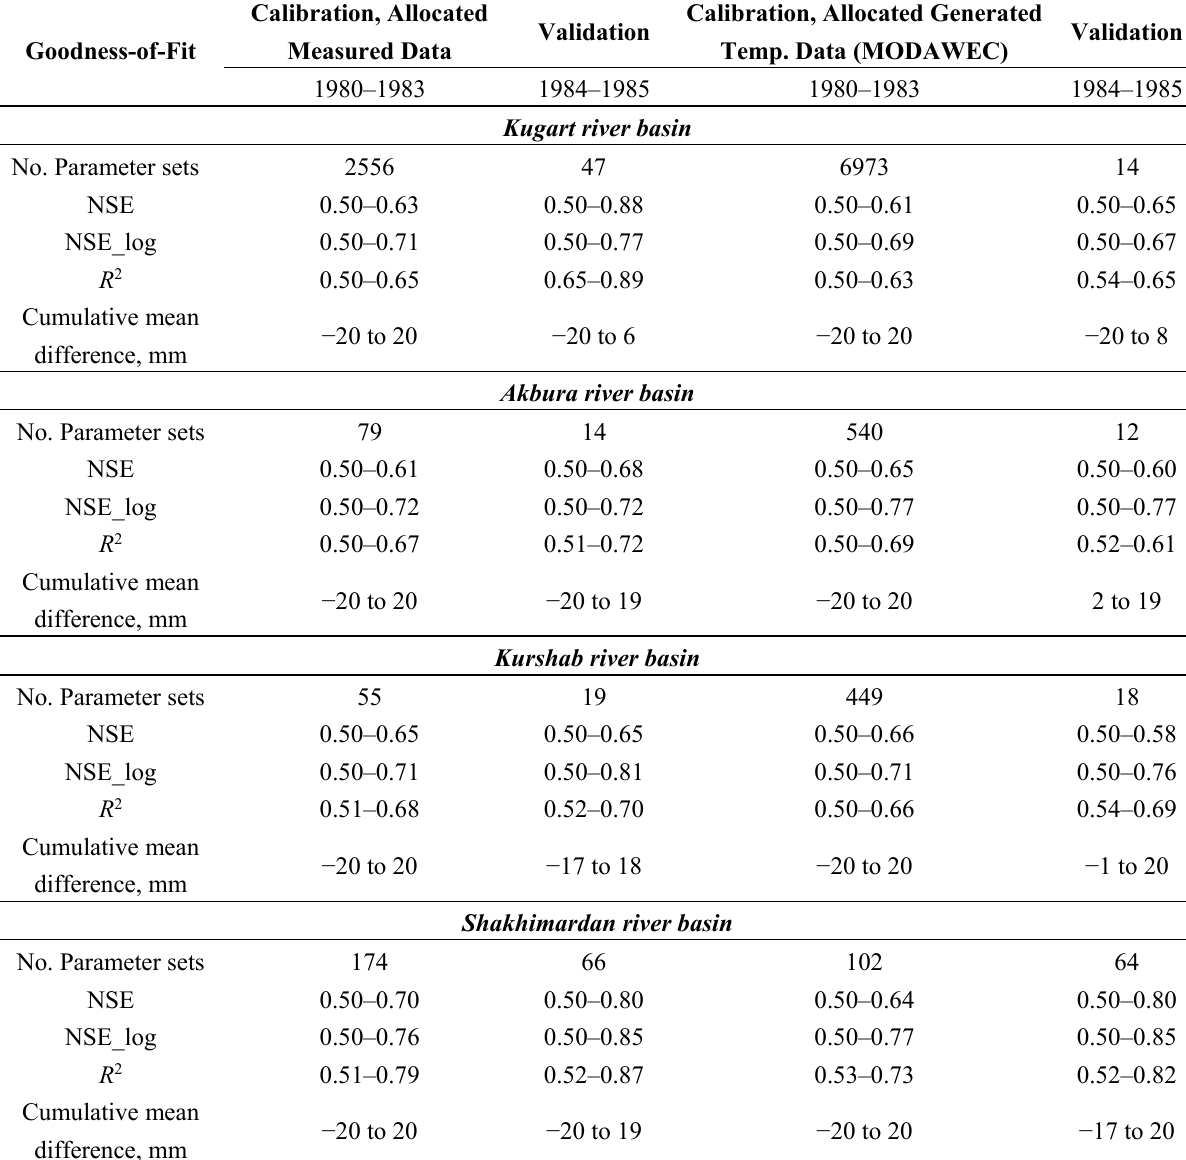
Table 4. Results of calibration and validation of the HBV-light model using allocated measured and generated temperature data, and MLR-calculated precipitation of the four pilot